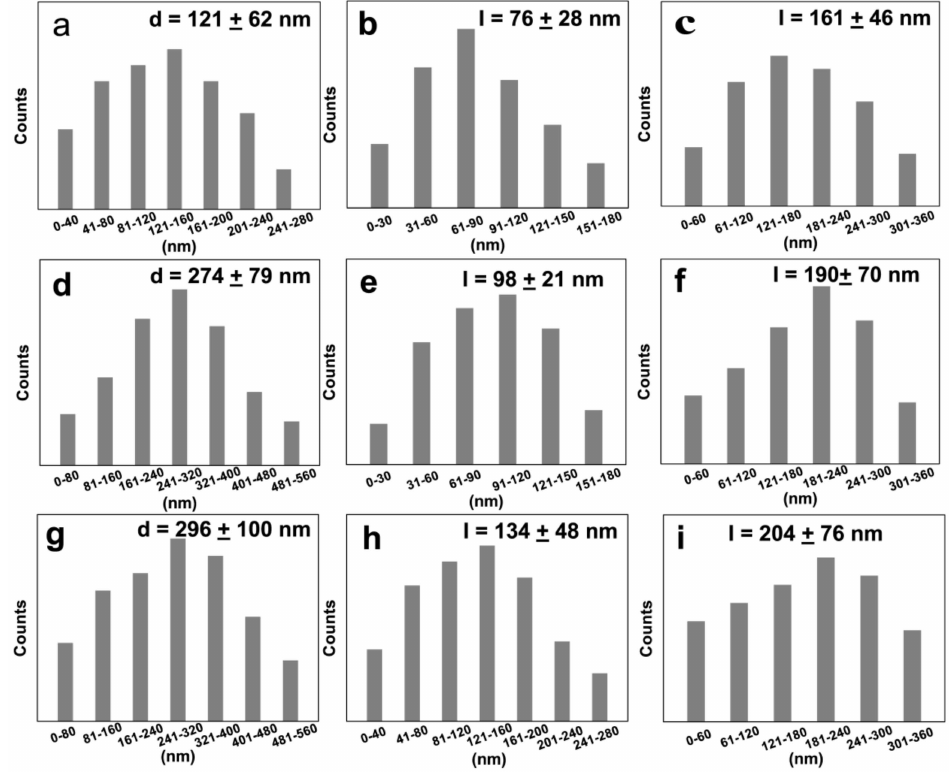
Figure 3. The corresponding size distribution of MAPbI 3 nanoplates, nanocubes, and nanorods dried at 50 ◦ C ( a – c ), 70 ◦ C ( d – f ), and 95 ◦ C ( g – i